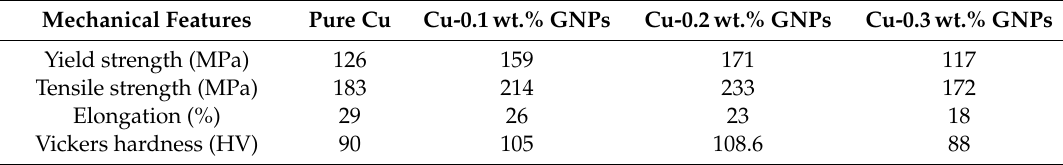
Table 7. Mechanical properties of pure copper and its nanocomposites in the presence of various GNPs content